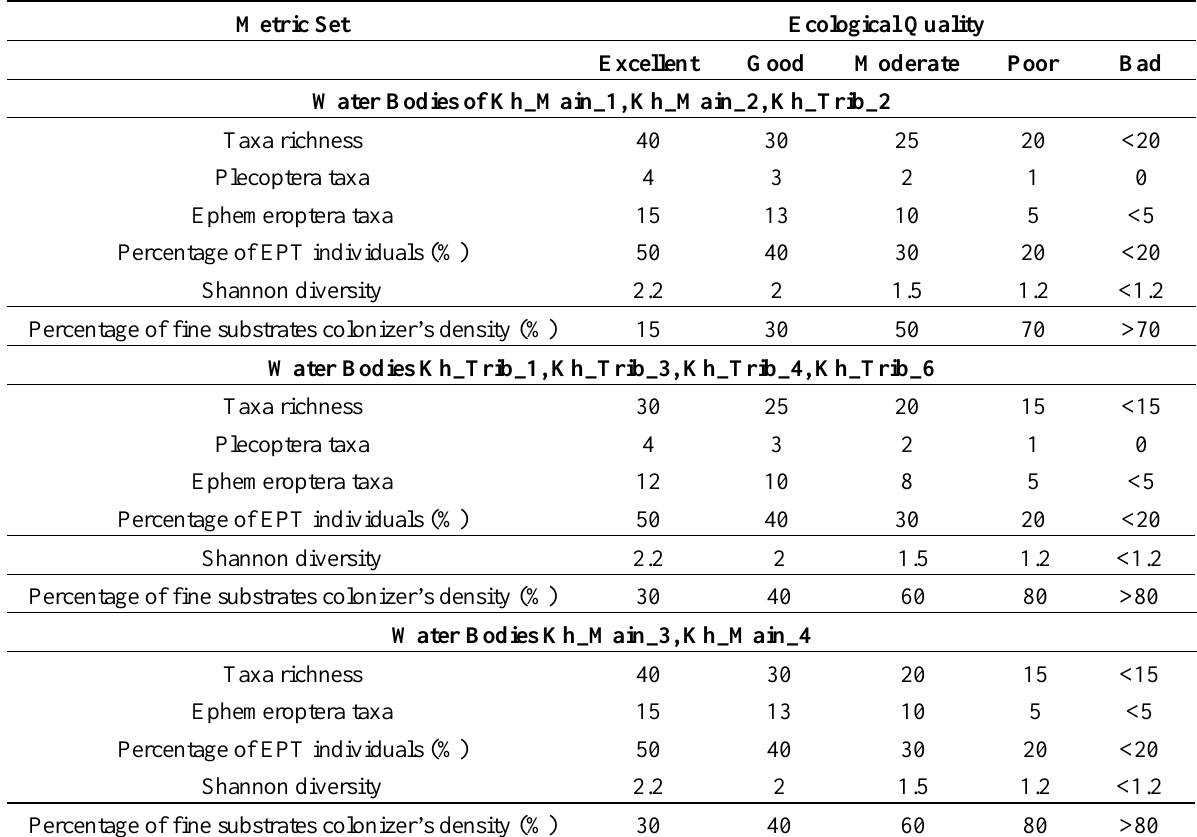
Table 2. Threshold values of metrics used for ecological quality assessments by benthic invertebrate assemblages in the KRB. For explanation of water bodies and river types see Tables 4 and